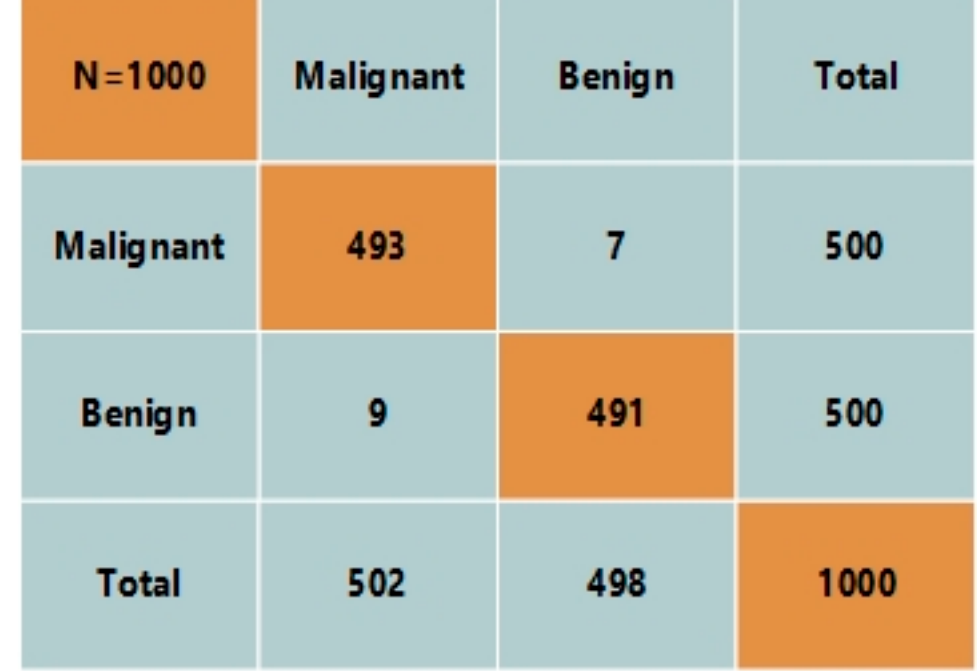
Figure 8 . Confusion matrix for cross-validation . Figure 8. Confusion matrix for